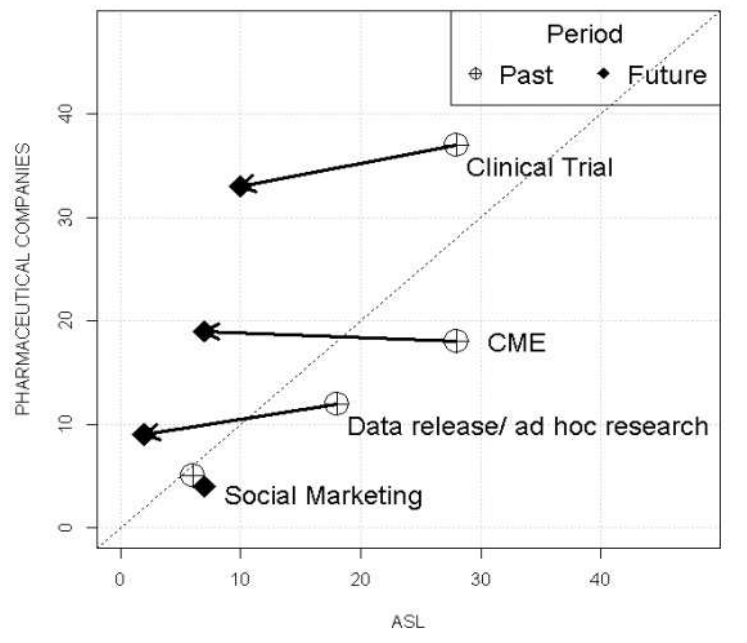
Source: Research Centre B-ASC. Based on research